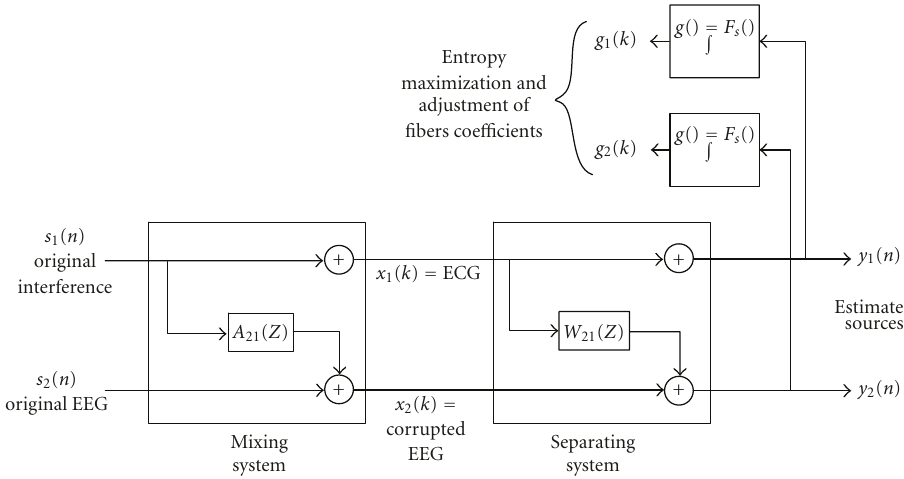
Figure 11: Network architecture for our modified ICA